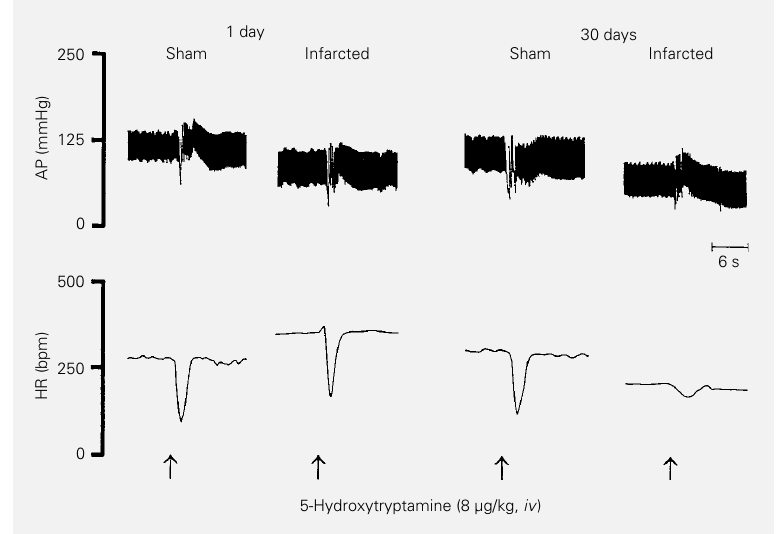
Figure 4 - Typical recording showing the changes in arterial pressure (AP) and heart rate (HR) in response to 5-hydroxytryptamine in an acute (1 day) and a chronic (30 days) myocardial infarcted rat (infarcted) compared with a sham-operated (sham) rat.